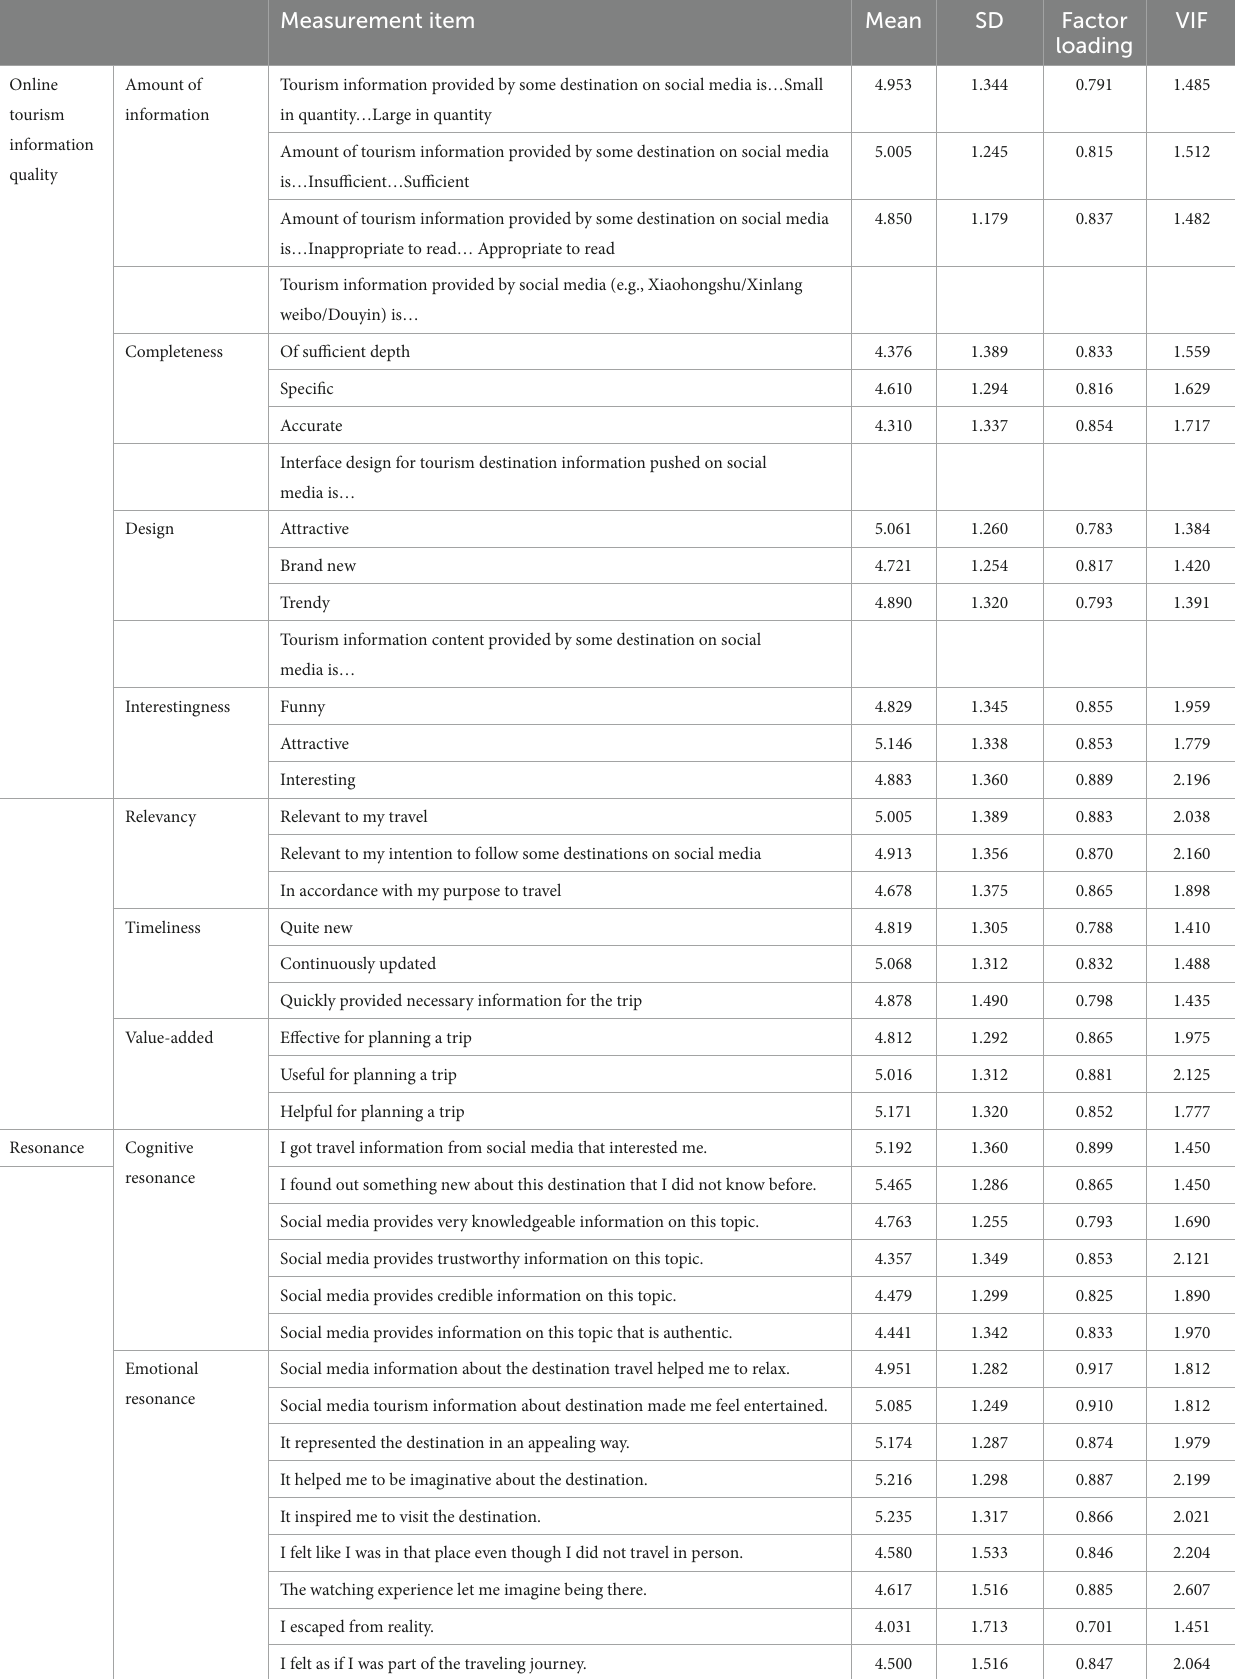
TABLE 2 Mean, standard deviation (SD), factor loading, and variance inflation factor (VIF) of 43 measurable items. Measurement item Mean SD Factor